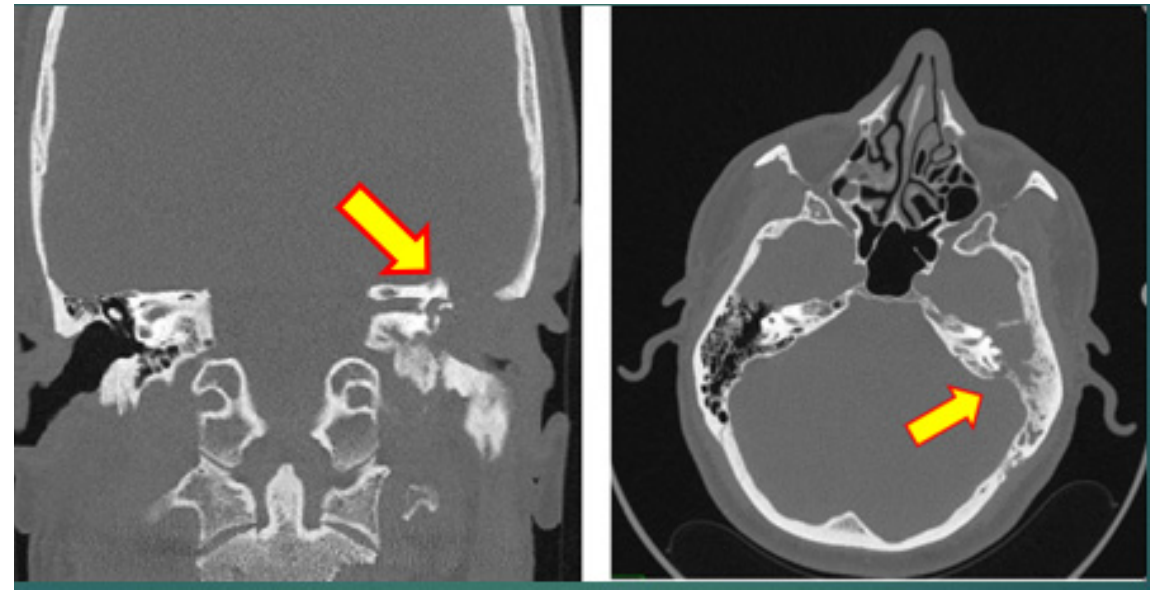
Figure 4. Pre-operative CT scan—case 2. Axial and coronal reconstruction of high-resolution tem- poral bone CT scan shows opacification of the mastoid air cells (right picture), and extensive bone destruction of the left mastoid bone and of the posterior wall of the external auditory canal, including the cochlea and vestibule (left picture).